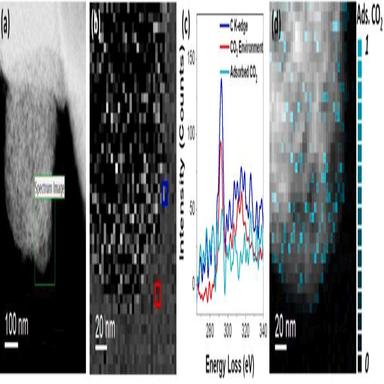
In situ observation of CO2 adsorption in ETEM using EELS. (a) STEM-ADF image of the pristine MCM-41 in a CO2 environment. (b) Carbon K-edge map measured from the indicated area in (a). (c) EELS spectral features attributed to CO2 (blue), CO2 environment (red), and adsorbed CO2 (cyan), measured from the pixels marked by the blue and red squares, respectively, in (b). (d) CO2 adsorption map with an intensity scale normalized to the intensity maximum.